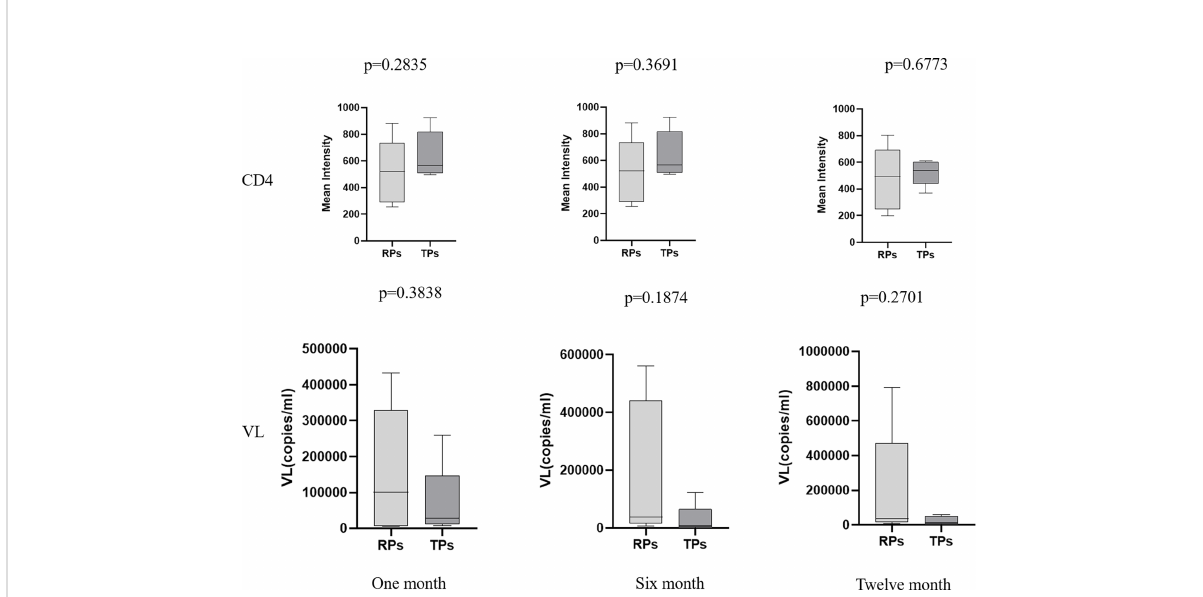
FIGURE 1 The comparison of CD4 and virus load (VL) at month 1, 2, and 12 in the TPs and